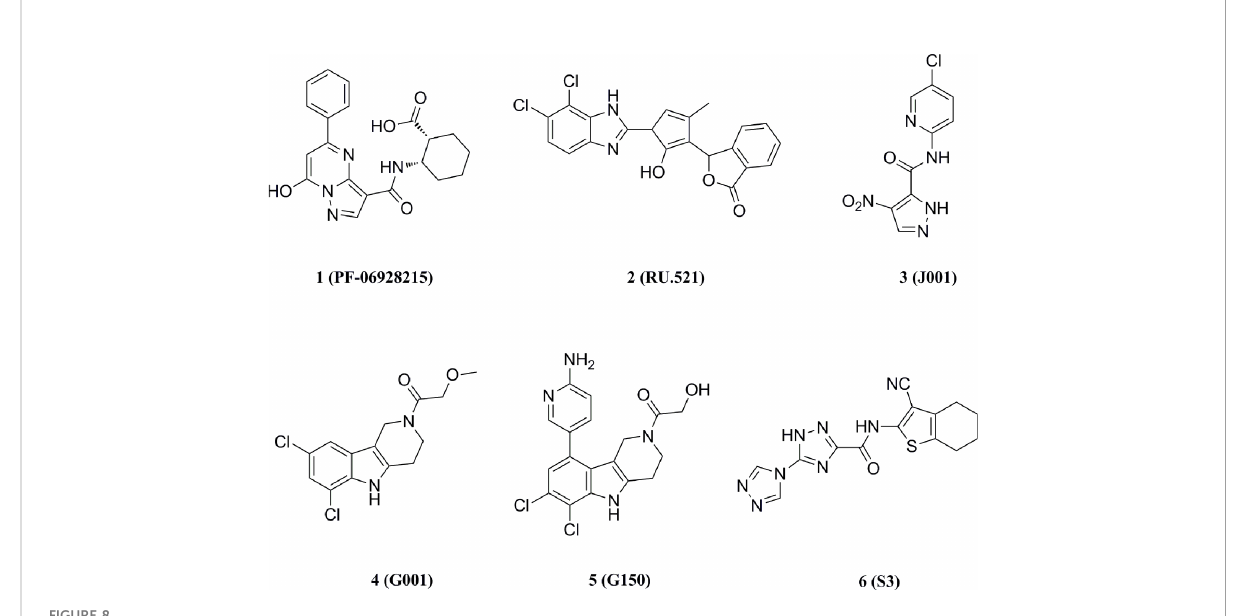
FIGURE 8 Structures of cGAS inhibitors targeting catalytic